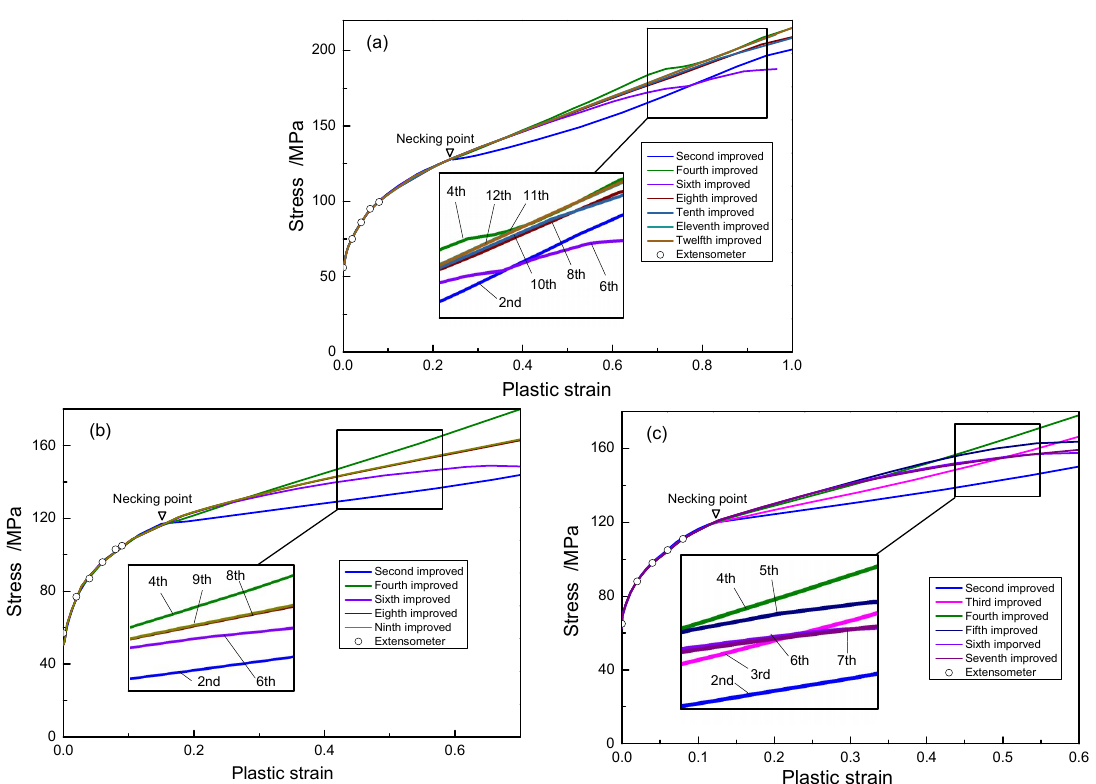
Figure 4. Improved stress-plastic strain curves by inverse method at different strain rates ( a ) 0.005 s −1 ( b ) 0.02 s −1 ( c ) 0.1 s −1 .